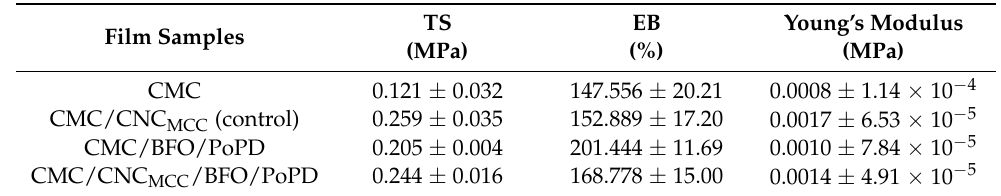
Table 2. Mechanical properties of the composite films in terms of tensile strength (TS), elongation at break (EB), and Young Modulus (YM).